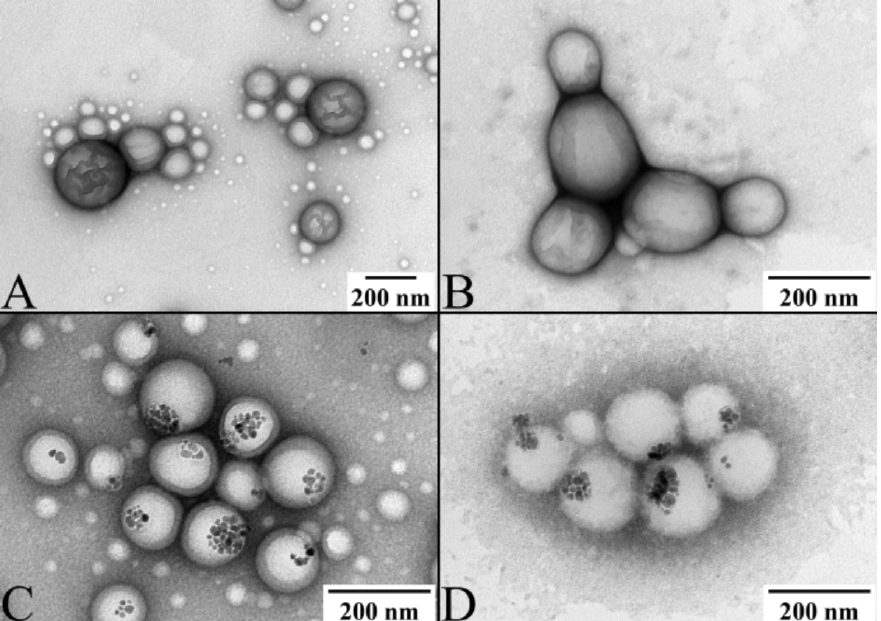
Figure 8. Transmission electron microscopy images of the oxaliplatin-loaded PLGA nanoparticles, PLGA_OXA ( A ); anti-CD133 antibody conjugated oxaliplatin loaded PLGA nanoparticles, PLGA_OXA_Ab ( B ); multicomponent PLGA based delivery system, PLGA_IO-OA_OXA ( C ) and anti-CD133 antibody conjugated multicomponent PLGA-based delivery system, PLGA_IO-OA_OXA_Ab ( D ).